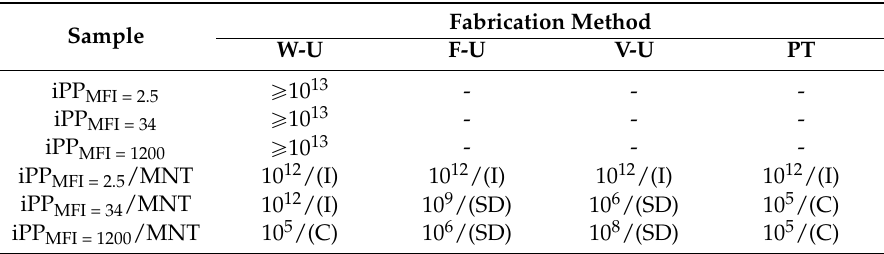
Table 4. Surface resistivity ( Ω /sq) for iPP homopolymers, and iPP/MNT nanocomposites fabricated by different